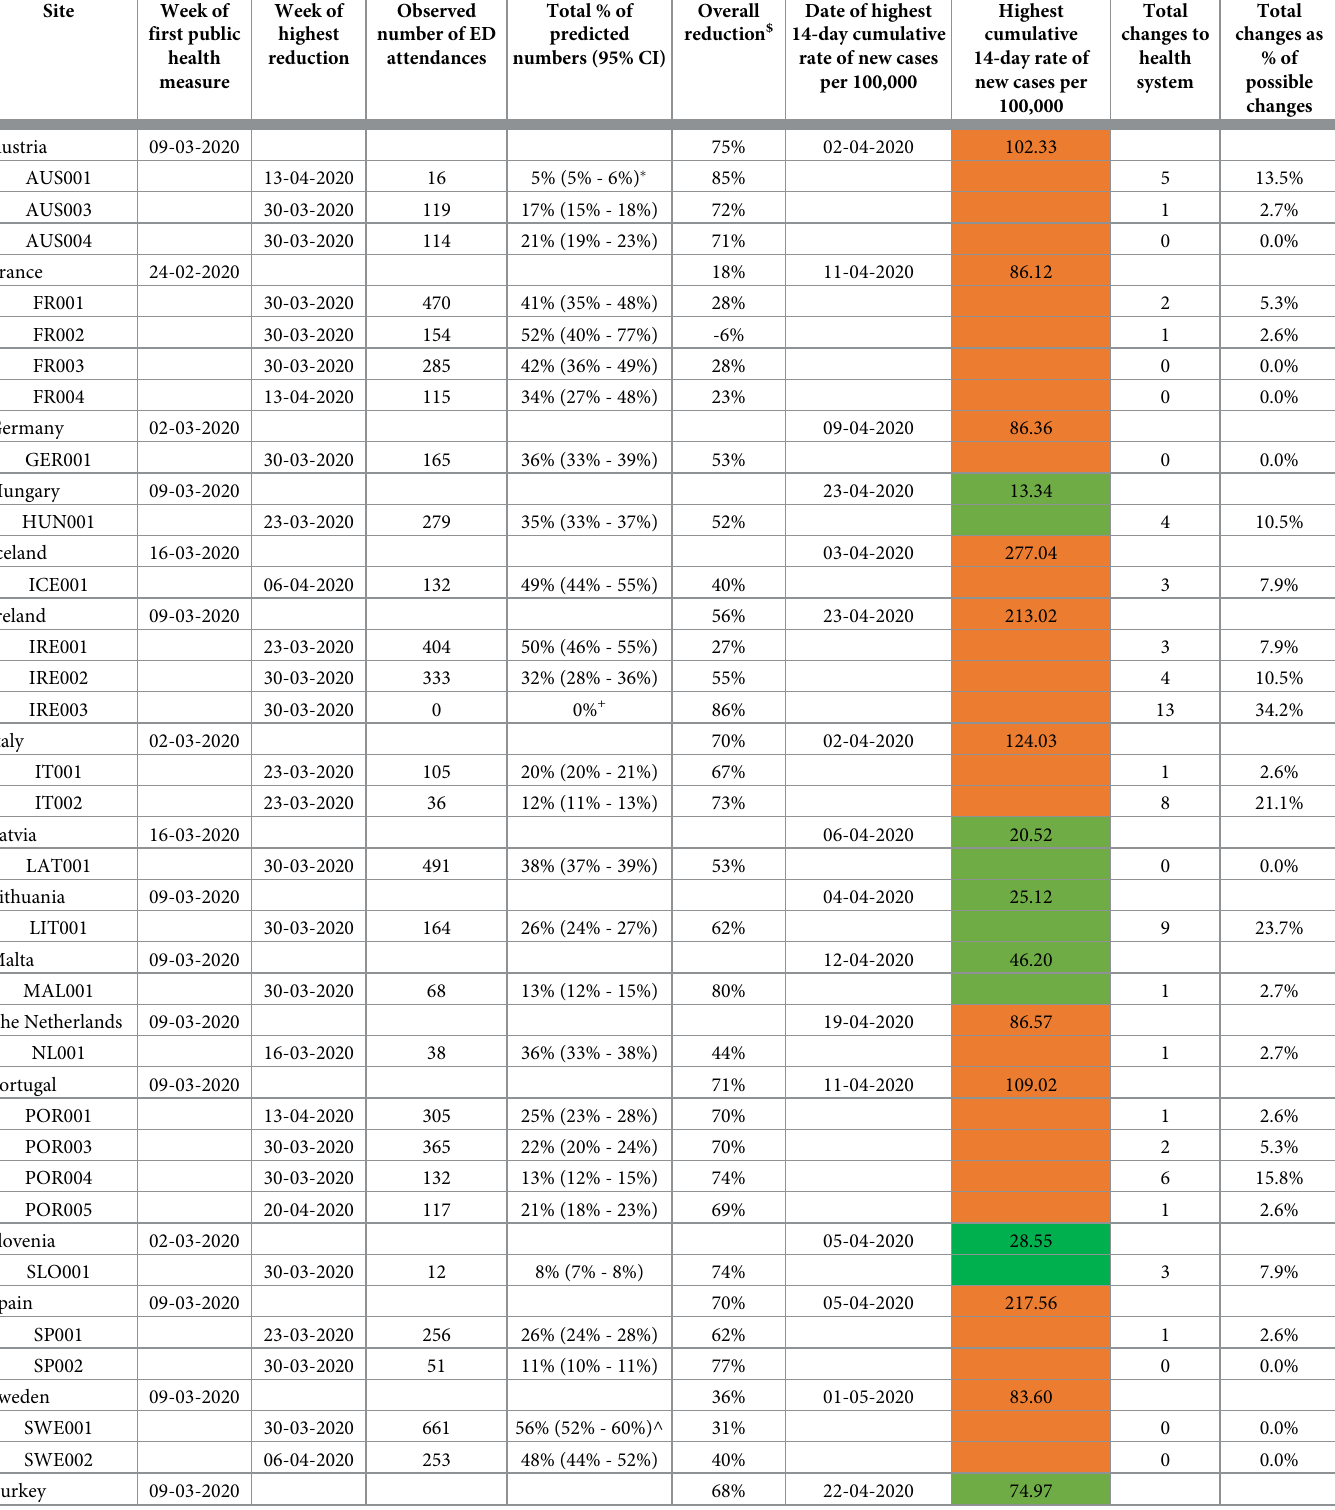
Table 1. Summary data on the lowest observed number of ED attendances during COVID-19 for each participating center.